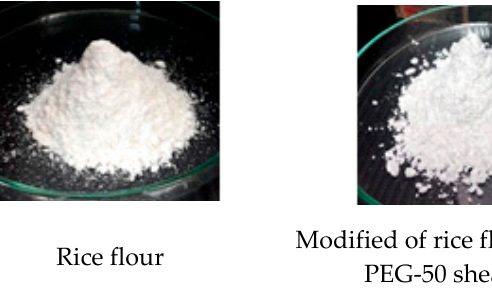
Figure 1. The appearance of the